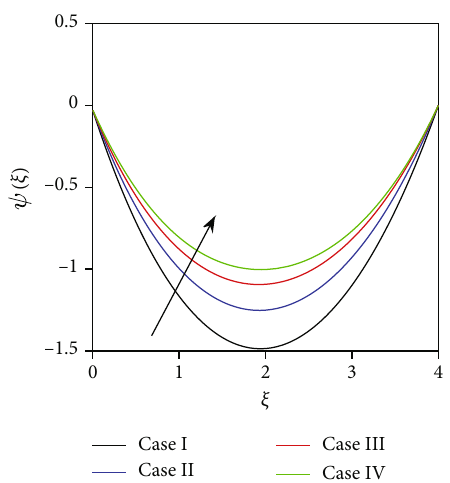
Figure 9: Radial velocity pro fi les for micropolar material constants A 1 – A 6